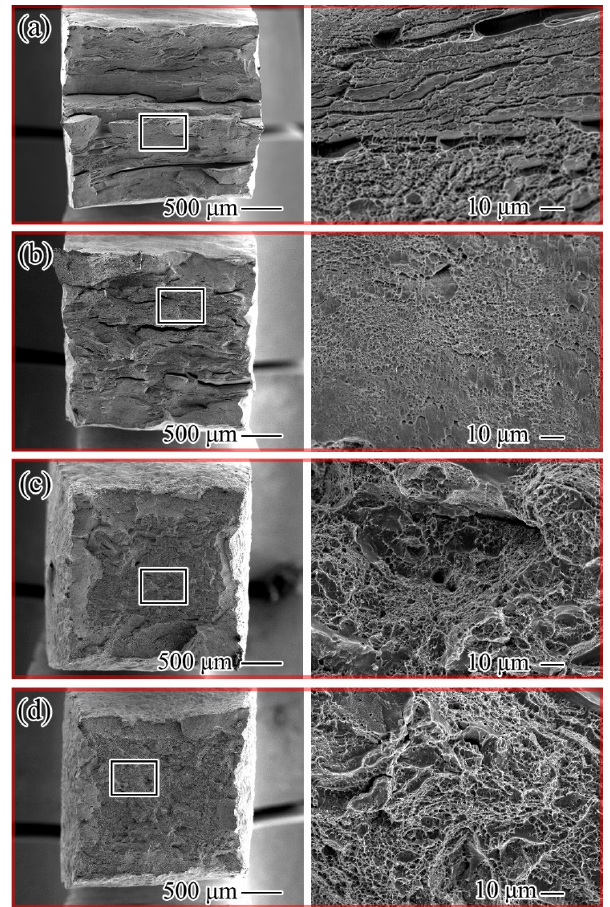
Figure 8. Fracture morphology of the annealed Ti-20Zr-15Mo alloy: ( a ) 500 °C; ( b ) 600 °C; ( c ) 700 °C; ( d ) 800 °C.